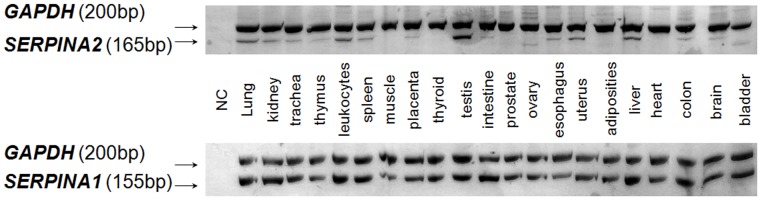
Expression ofSERPINA2 and SERPINA1 in human tissues.Duplex PCRs carried out in a cDNA panel from human healthy organs, each one including a minimum of three donor’s pool. GAPDH amplification was used as internal control. NC – Negative Control.